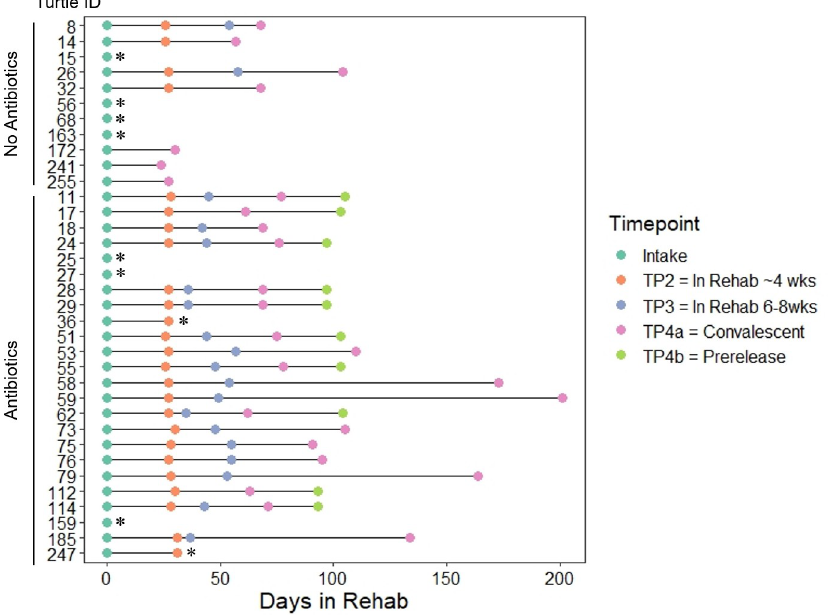
Fig 1. Oral and cloacal samples collected through rehabilitation. Swabs collected for each individual turtle (y axis) during rehabilitation. Each color denotes the timepoint in rehab. Convalescence (TP4a) is when the turtle is considered clinically healthy. Prerelease (TP4b) was only collected on turtles that remained in the hospital > 30 days after TP4a was collected. Whether antibiotics were received or not is indicated on the y axis. � indicates that the turtle died after that sample was